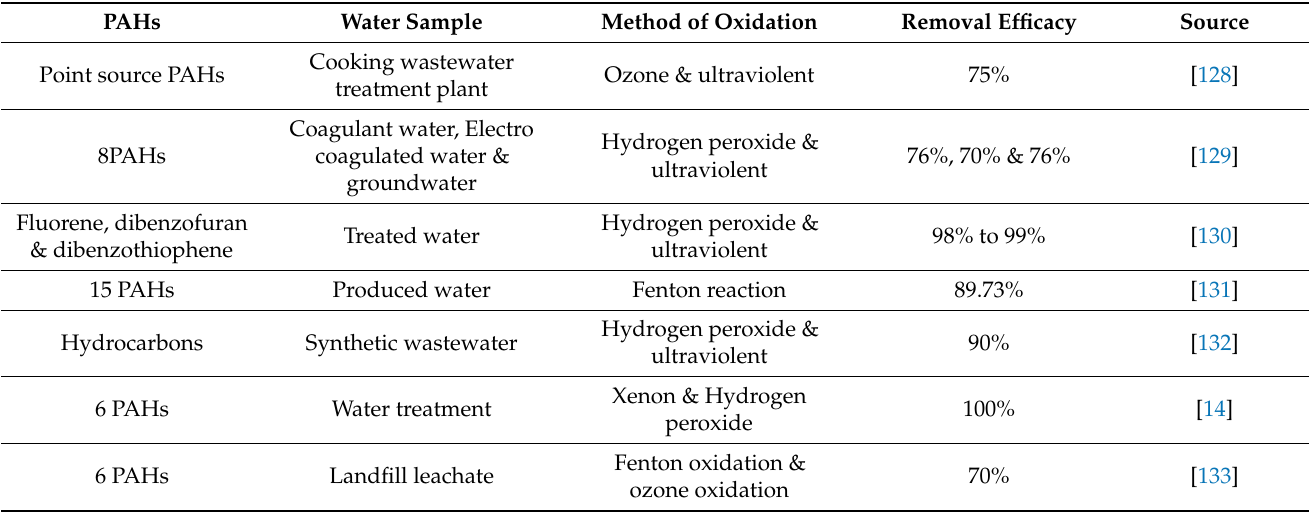
Table 6. Methods of oxidation for removal of PAHs from water